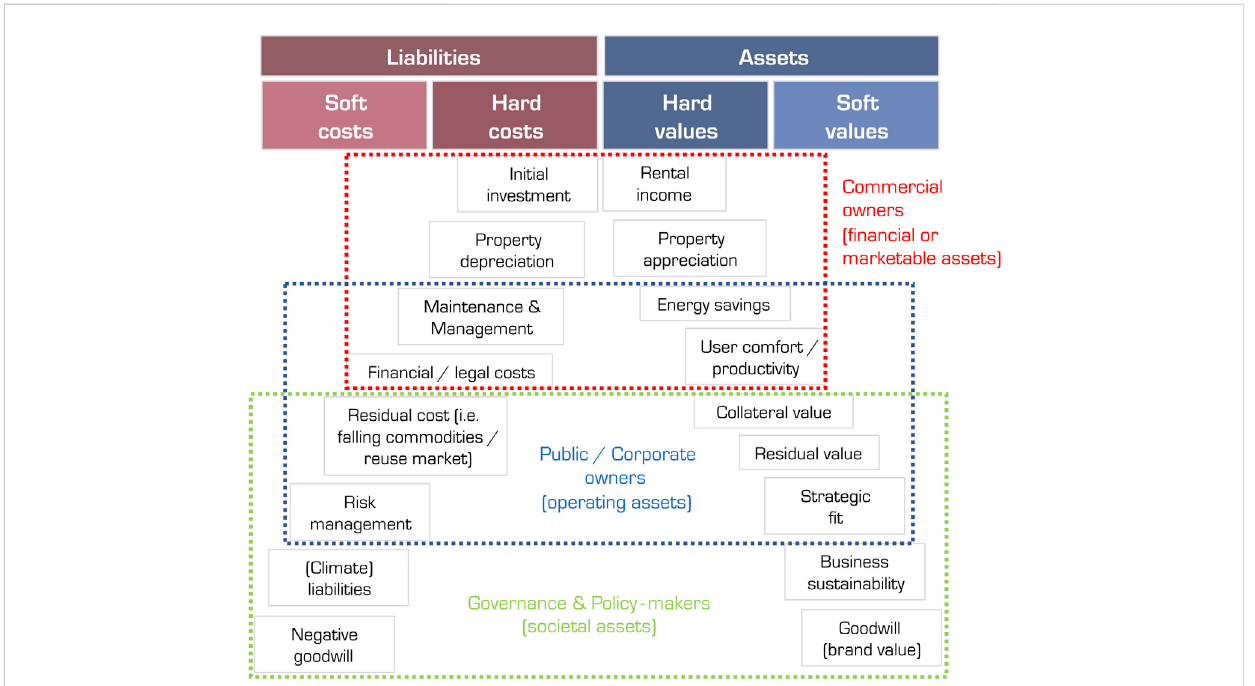
FIGURE 3 Non-exhaustivediagramofsoftandhardvaluesandcostsinstrategicrealestatedecisions.Highlightedthoseparametersmostrelevanttoeachtype of building owner. Adapted from (Azcarate-Aguerre et al., 2022).